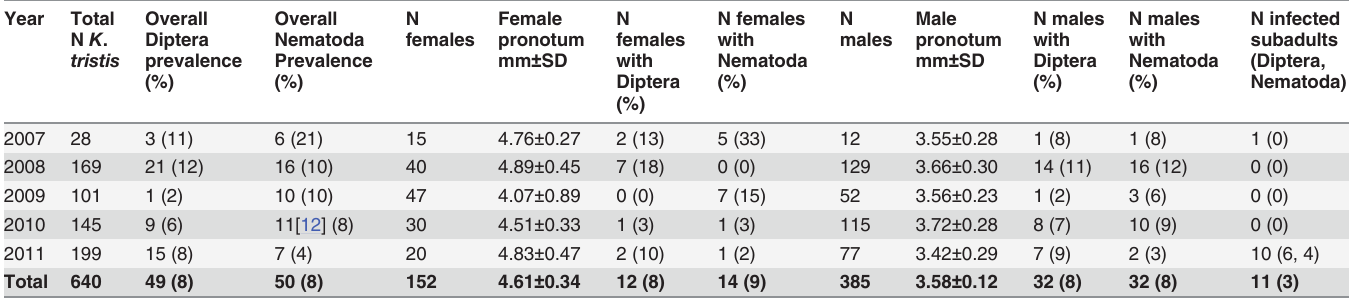
Overall numbers of infected individuals are presented, as well as numbers of females and males infected and their pronotum length (proxy for body size). Final row provides total counts for prevalence and averages for pronotum